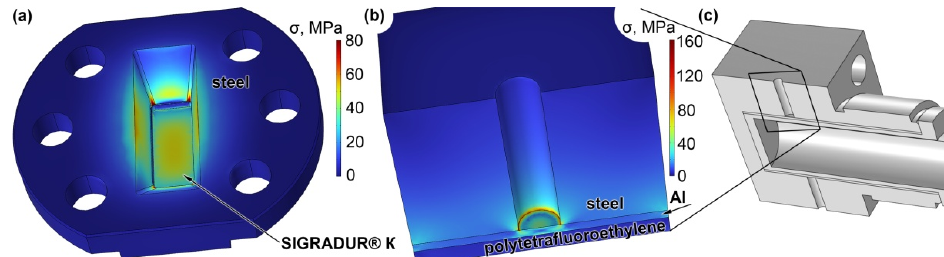
Figure 4. Von Mises stress ( σ ) distribution for fluorescence ( a ) and transmission ( b ) cells. Panel ( c ) shows the part of the transmission cell used for calculations.